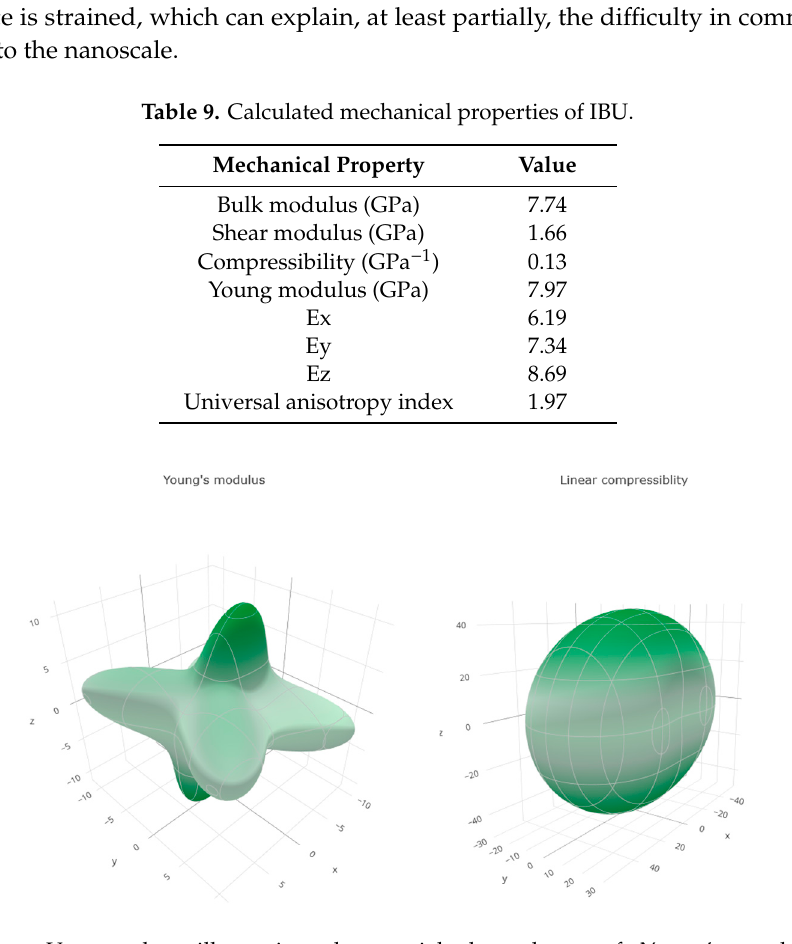
Figure 11. Vector plots illustrating the spatial dependence of Young’s modulus and linear compressibility.